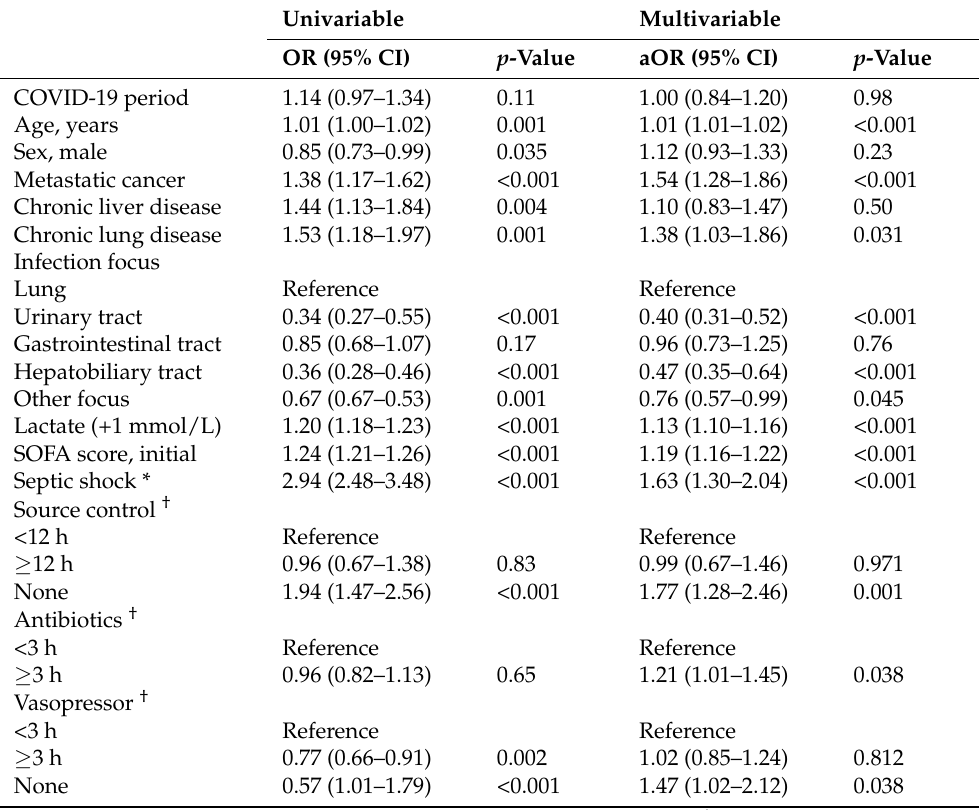
Table 4. Univariable and multivariable logistic regression analysis of in-hospital mortality. Univariable